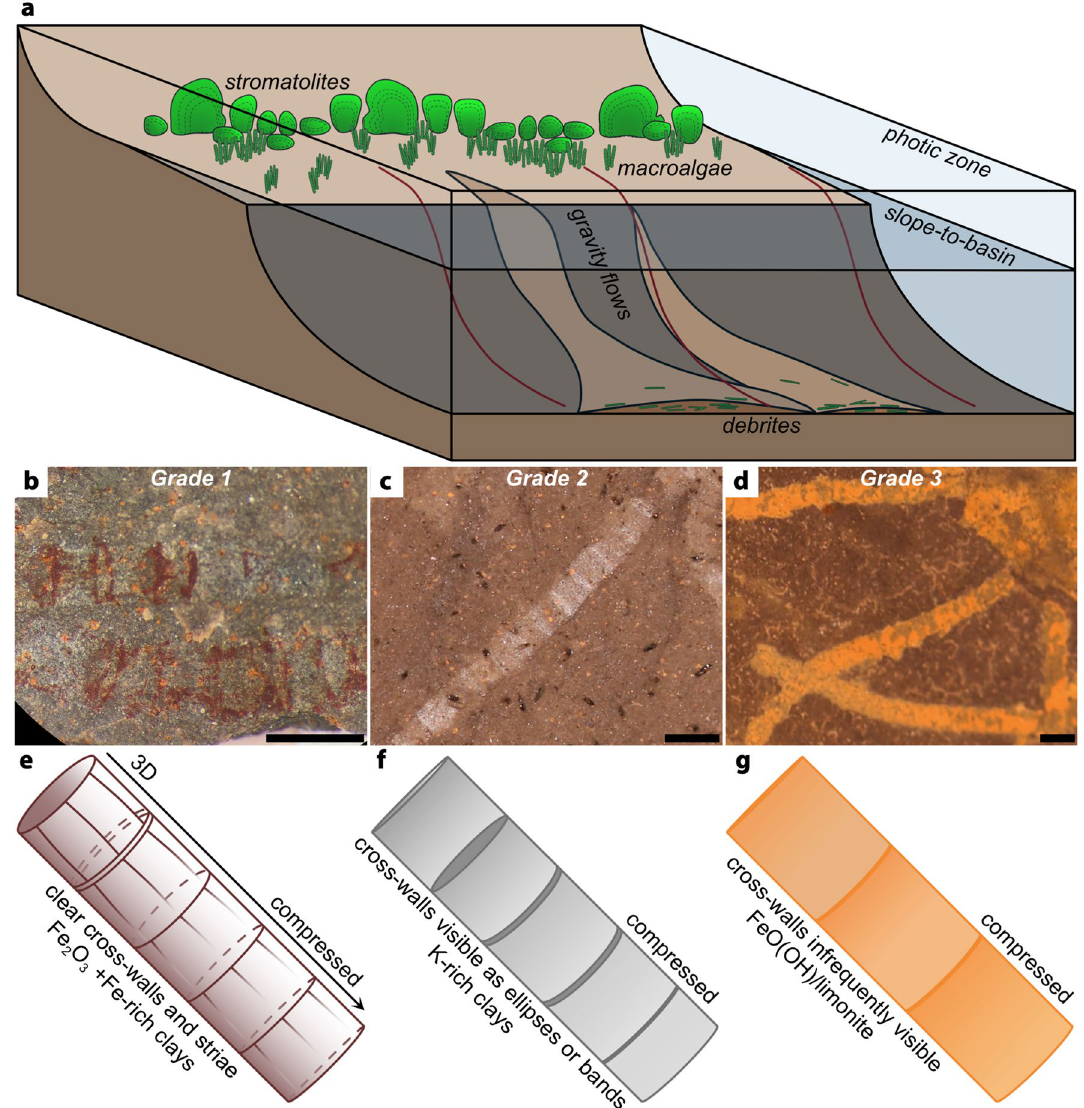
Figure 6. Taphonomic model for the Dolores Creek macroalgal fossils. ( a ) Depositional setting with the organisms in life position on the outer-shelf. Organisms are transported downslope and buried by gravity flows. Macroalgae decays and fossilization occurs. ( b – d ) Specimen photos showing variation in preservation grades 1–3. ( e ) Grade 1 fossils have pyritized cross-walls and side walls (as indicated by the presence of Fe 2 O 3 and abundance of SO 42– or sulfate), while the cell segments are preserved by aluminosilicification with Fe-rich clays. ( f ) Grade 2 fossils have visible cross-walls and side walls preserved by aluminosilicification with K-rich clays. ( g ) Grade 3 fossils have poorly pyritized cell boundaries because the abundant sulfate and iron in an anoxic environment resulted in the rapid precipitation of